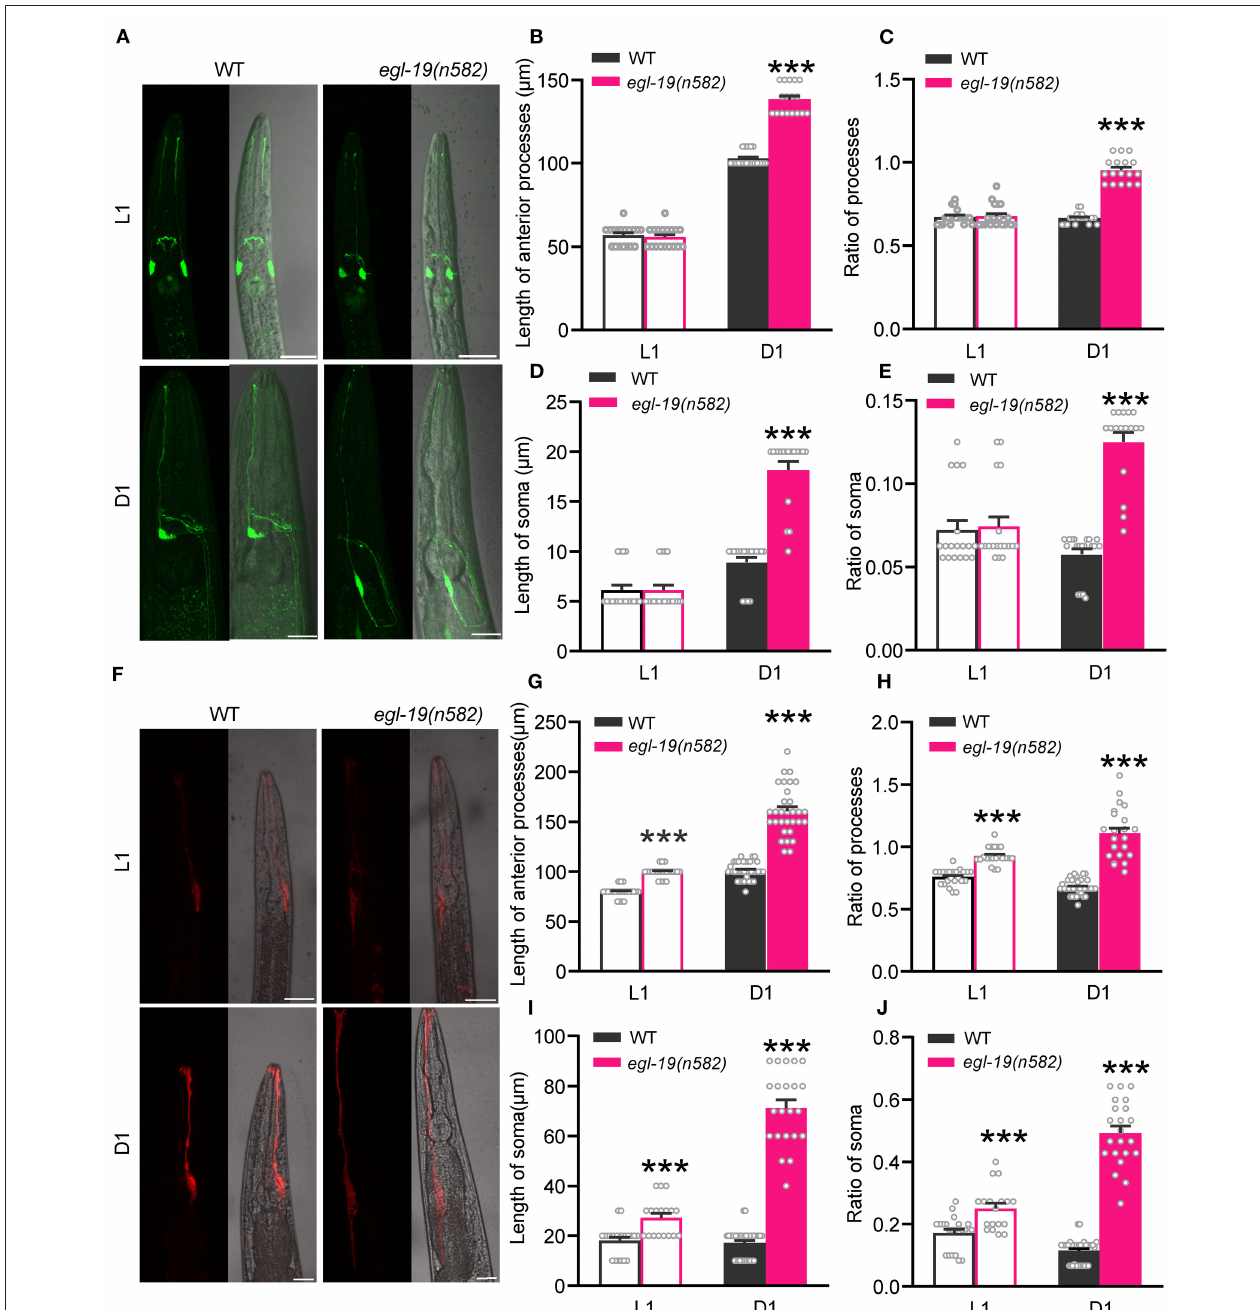
FIGURE 3 | The morphologies of both AMsh glia and ASH neuron were modulated by EGL-19. (A) Representative morphologies of ASH neurons (green, labeled with Psra-6::GFP ) in wild type and egl-19(n582) mutants at L1 stage (upper) and D1 stage (lower), respectively. Scale bar, 20 µ m. (B,D) The lengths of the anterior processes (B) and soma (D) of ASH neurons in wild type and egl-19(n582) mutants at L1 and D1 stage. (C,E) The Ratio of the lengths of the anterior processes (C) and soma (E) of ASH neurons to the lengths of the second pharynx in wild type and egl-19(n582) mutants at L1 and D1 stage. The lengths of the second pharynx is calculated as the distance from nose tip to the middle of the second pharynx. L1 stage [WT (ST2169), n = 18; egl-19(n582) (ST2993), n = 18]; D1 stage [WT, n = 19; egl-19(n582) , n = 17]; unpaired t -test. (F) Representative morphologies of AMsh glia (red, labeled with Pvap-1::mCherry ) in wild type and egl-19(n582) mutants at L1 (upper) and D1 (lower), respectively. Scale bar, 20 µ m. (G,I) The lengths of the anterior processes (G) and soma (I) of AMsh glia in wild type and egl-19(n582) mutants at L1 and D1 stage. (H,J) The Ratio of the lengths of the anterior processes (H) and soma (J) of AMsh glia to the lengths of the second pharynx in wild type and egl-19(n582) mutants at L1 and D1 stage. L1 stage [WT (ST826), n = 21; egl-19(n582) (ST993), n = 18]; D1 stage [WT, n = 21; egl-19(n582) , n = 20]; unpaired t -test. Error bars represent SEM. *** p < 0.001.